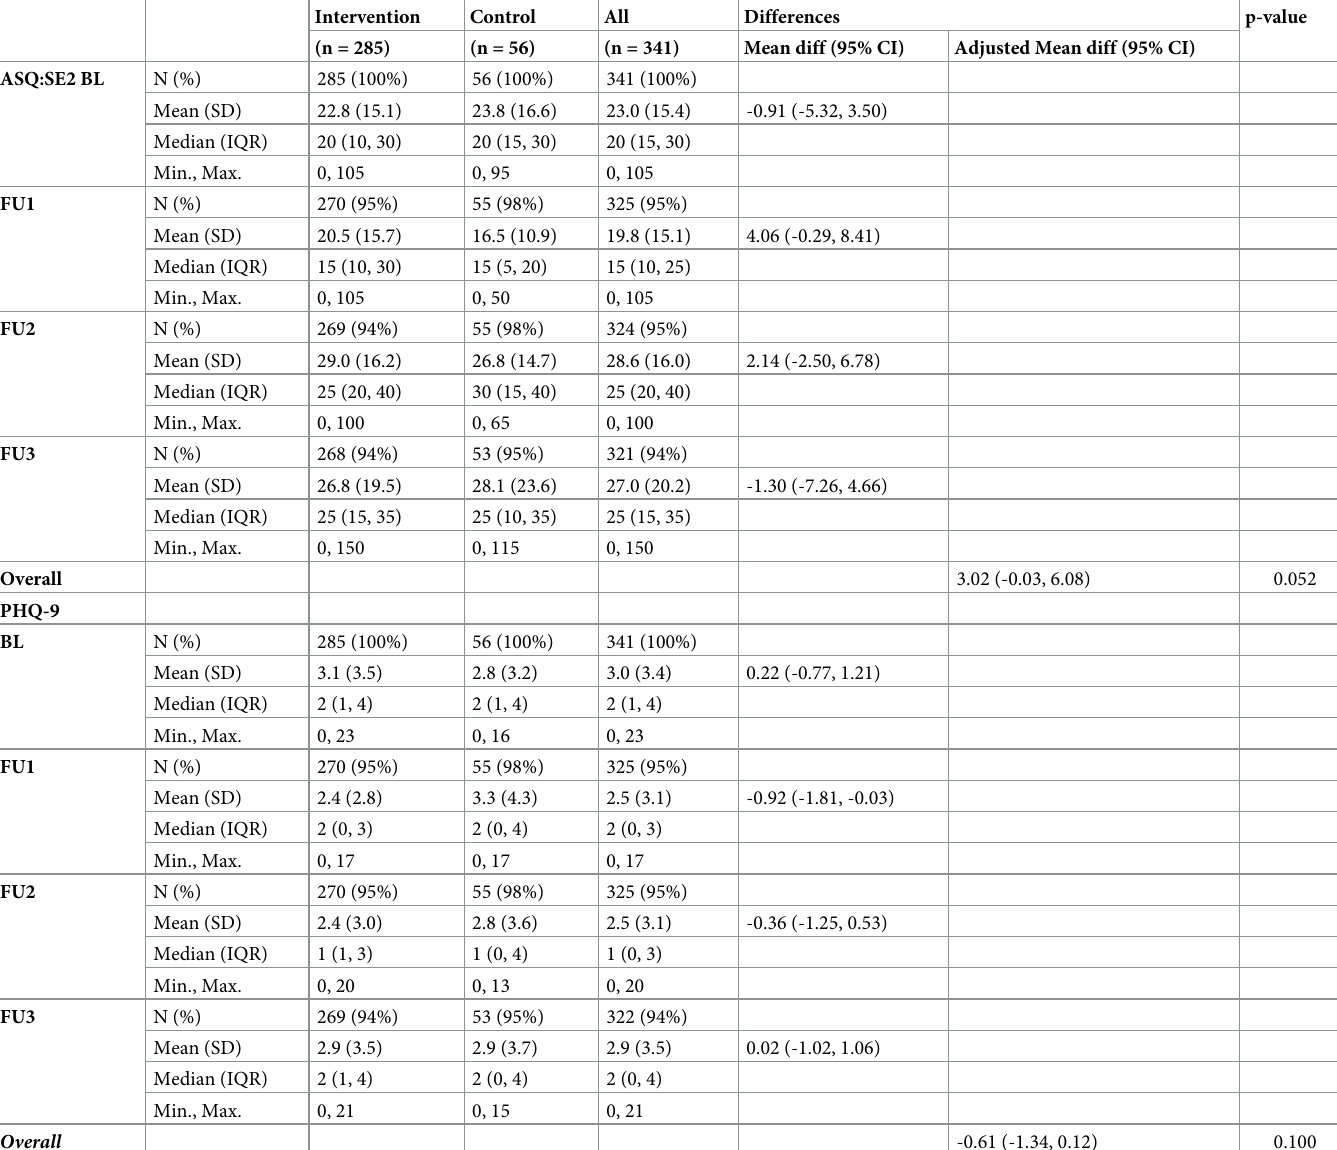
Table 2. Difference between arms for primary and key secondary outcomes. Intervention Control All Differences